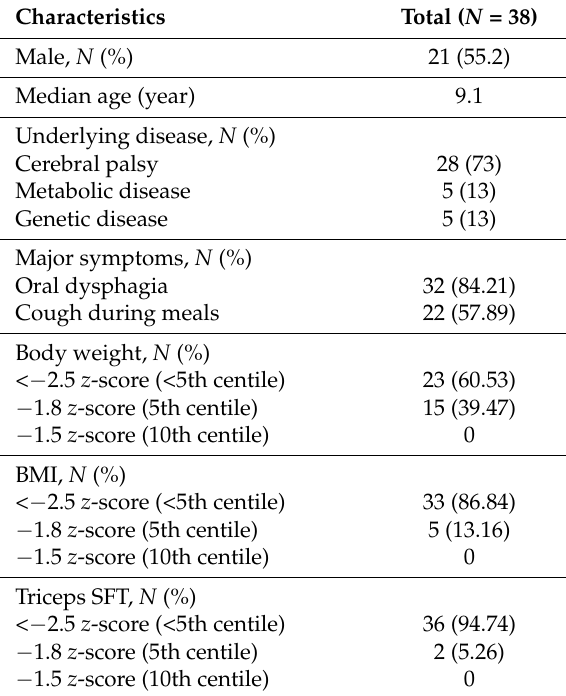
Table 1. Demographic and clinical